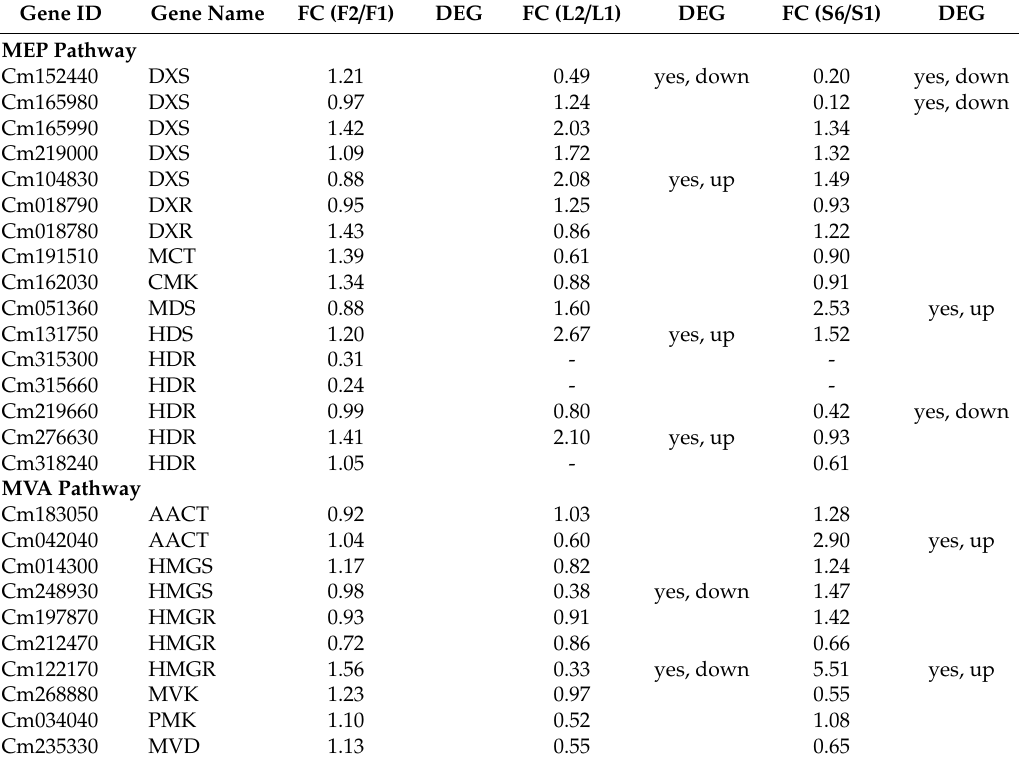
Table1. TheFPKMfoldchange(FC)ofstructuregenesinterpenoidsynthesisduringorgandevelopment. Gene